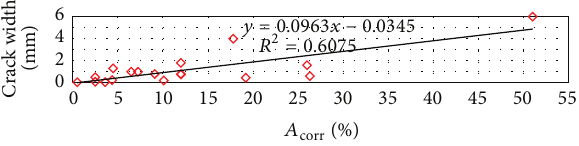
Figure 5: Crack width versus percentage loss of cross section regresses from results represented in Table